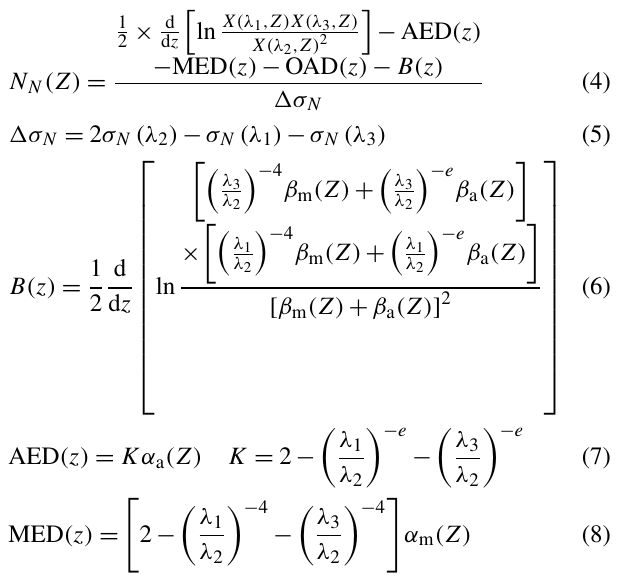
Fig. 2, a bumping absorption method ( σ N (λ 1 ) < σ N (λ 2 ) & σ N (λ 3 ) < σ N (λ 2 ) ) is designed to choose the three wavelengths which can increase the value of (cid:49)σ N com- ing to Eq. (12). However, for DIAL systems to